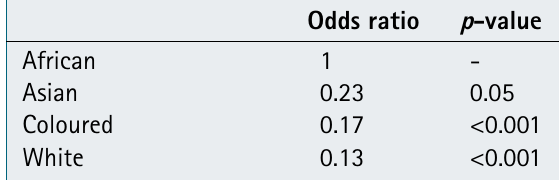
TABLE i. oDDS RATioS FoR HiV inFECTion in DiFFEREnT RACE GRoUpS BASED on A MULTiVARi- ATE AnALYSiS oF THE 1998 AnD 1999 HiV AnTEnATAL SURVEY DATA 11